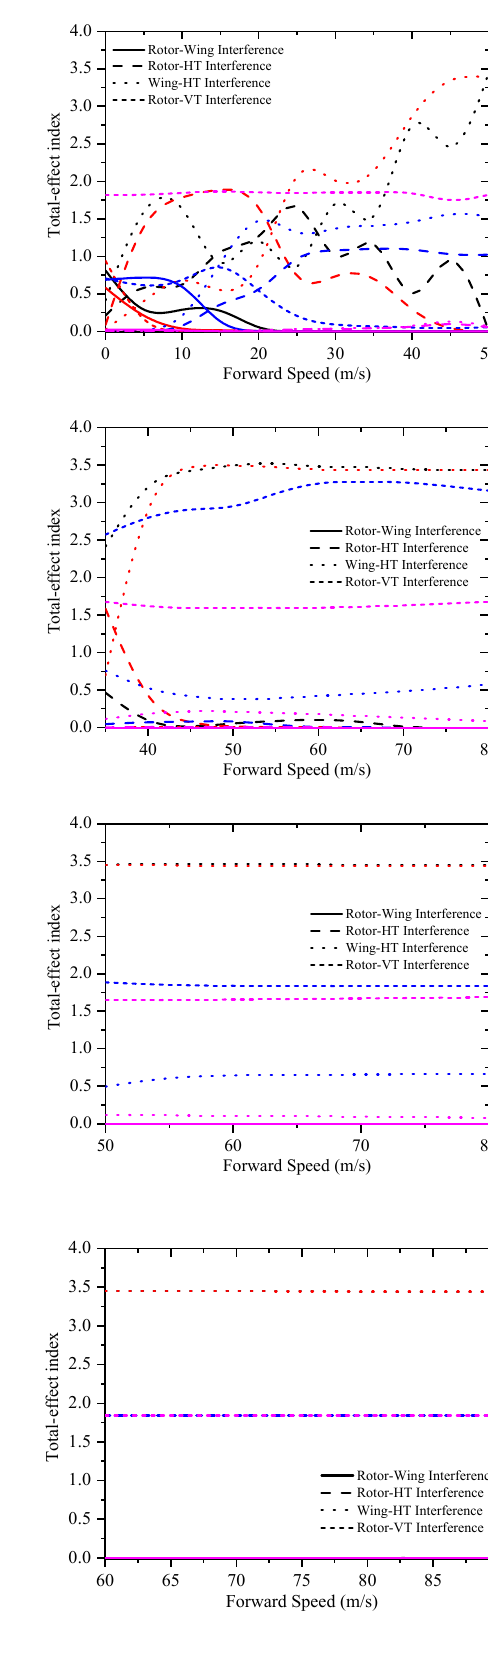
Figure 6. Stability derivative results. ( a ) Helicopter mode; ( b ) Conversion mode (30 Deg); ( c ) Con- version mode (60 Deg); ( d ) Airplane mode. Figure 6 indicates that the aerodynamic interference affects the longitudinal stability derivatives, namely, the velocity stability derivative ( δ q / δ V x ) and the incidence stability derivative ( δ q / δ V z ). The interference effect on dihedral-effect stability ( δ p / δ V y ) and head- ing stability derivative ( δ r / δ V y ) is much lower. The tiltrotor aircraft configuration is sym- metric, and the aerodynamic uncertainty effects are mainly related to the longitudinal and vertical channel. Consequently, its influence on the lateral/yawing channel is reduced. The effect of the aerodynamic interference on the velocity stability derivatives is most significant in the helicopter mode. During this flight range, the aerodynamic interferences, especially the rotor-horizontal tail interference and the wing-horizontal tail interference, alter the pitching moment provided by the wing and tailplane parts. Furthermore, as the velocity stability is close to zero in the helicopter mode, the aerodynamic interference may lead this stability derivative to be negative, resulting in the degradation in the handling qualities ratings. Compared to the uncertainty quantification results from Figure 3, the probability results decrease as the velocity stability range is close to zero, demonstrating a straightforward relationship between the interference-induced velocity stability incre- ment and the handling quality rating. When the pylon is tilted forward and forward speed increases, the velocity stability is improved. Therefore, only the wing-horizontal tail inter- ference can alter the velocity stability derivative in the conversion and aeroplane mode, and the corresponding influential magnitude is much lower than that in the helicopter mode. The aerodynamic interference alters the incidence stability to a large extent across the flight range. The wakes of the rotor and wing parts change the dynamic pressure and attack angle of various components in the vehicle. In the helicopter mode and the conver- sion mode with a lower nacelle angle, both rotor and wing wakes would influence the aerodynamics characteristics of the tailplane together. Therefore, a non-linear correlation between the uncertainty-induced incidence stability increment and forward speed can be observed because of the coupling effect between these two wakes. When the nacelle inci- dence changes to 60 Deg, only the wing and tailplane interference can be observed in terms of the incidence stability, and the corresponding uncertainty effect on incidence sta- bility grows with the forward speed. Based on Figure 6c, d, the incidence stability results are close to zero in high-speed flight, leading the handling qualities ratings to be de- graded, as shown in Figure 3. The slight influence on lateral/yawing stability is mainly due to the rotor-vertical tail interference. As shown in Figure 6, this influence cannot introduce a significant change in the relevant stability derivatives and consequently cannot affect the overall handling qual- ities. The sensitivity index also demonstrates indirect correlations between other interfer- ences and the lateral stability derivatives, especially during the helicopter mode. These